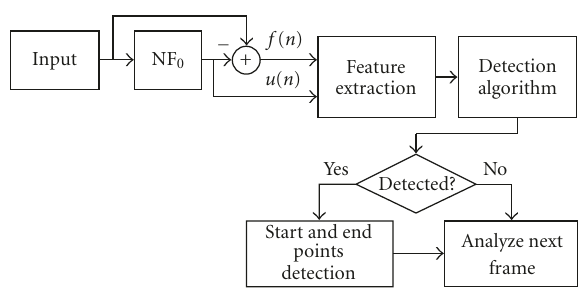
Figure 1: Block diagram of the detection technique of abnormal